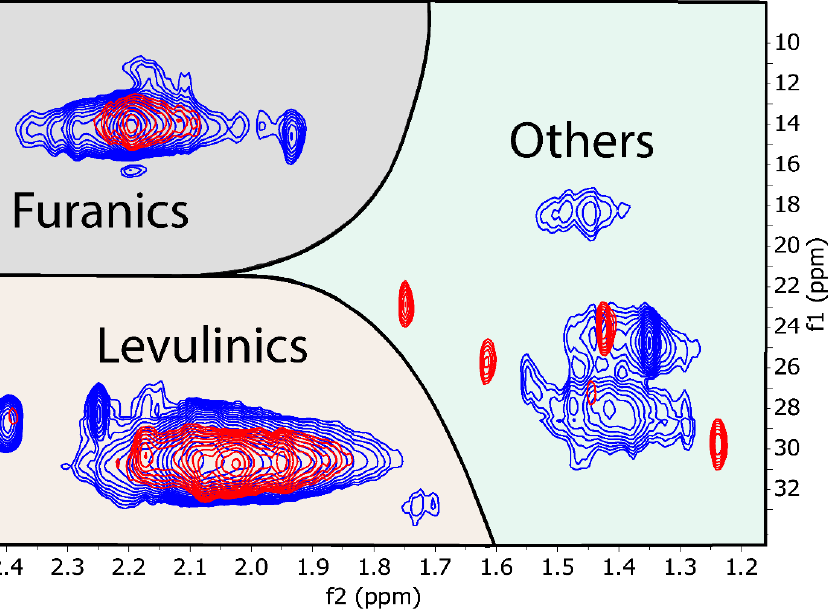
Figure 1. Magnified HSQC spectra of PFA+ (blue) and PFA° (red) of the CH 3 area. The red spectrum is stacked on top of the blue one.